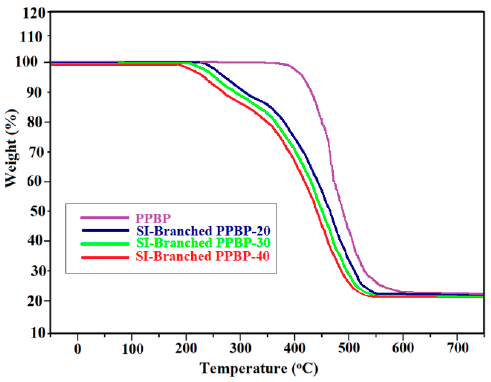
Figure 5. Thermogravimetric analysis (TGA) of SI-branched PPBP polymers.